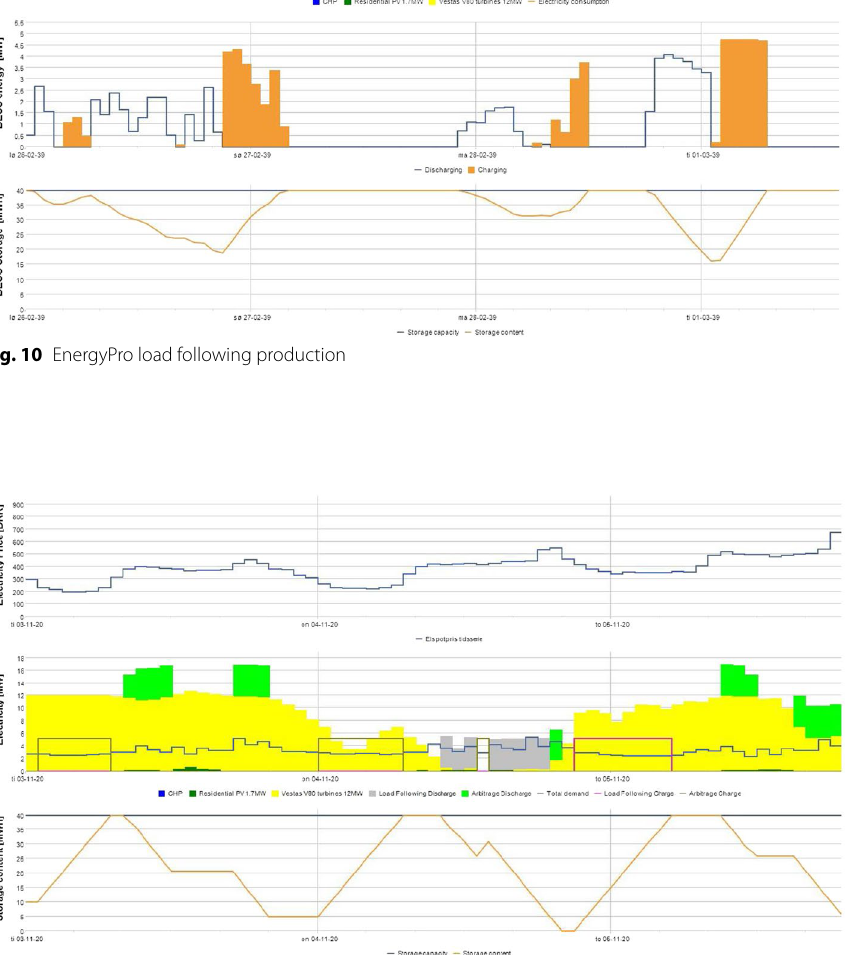
Fig. 11 EnergyPro production graphics of BESS including load